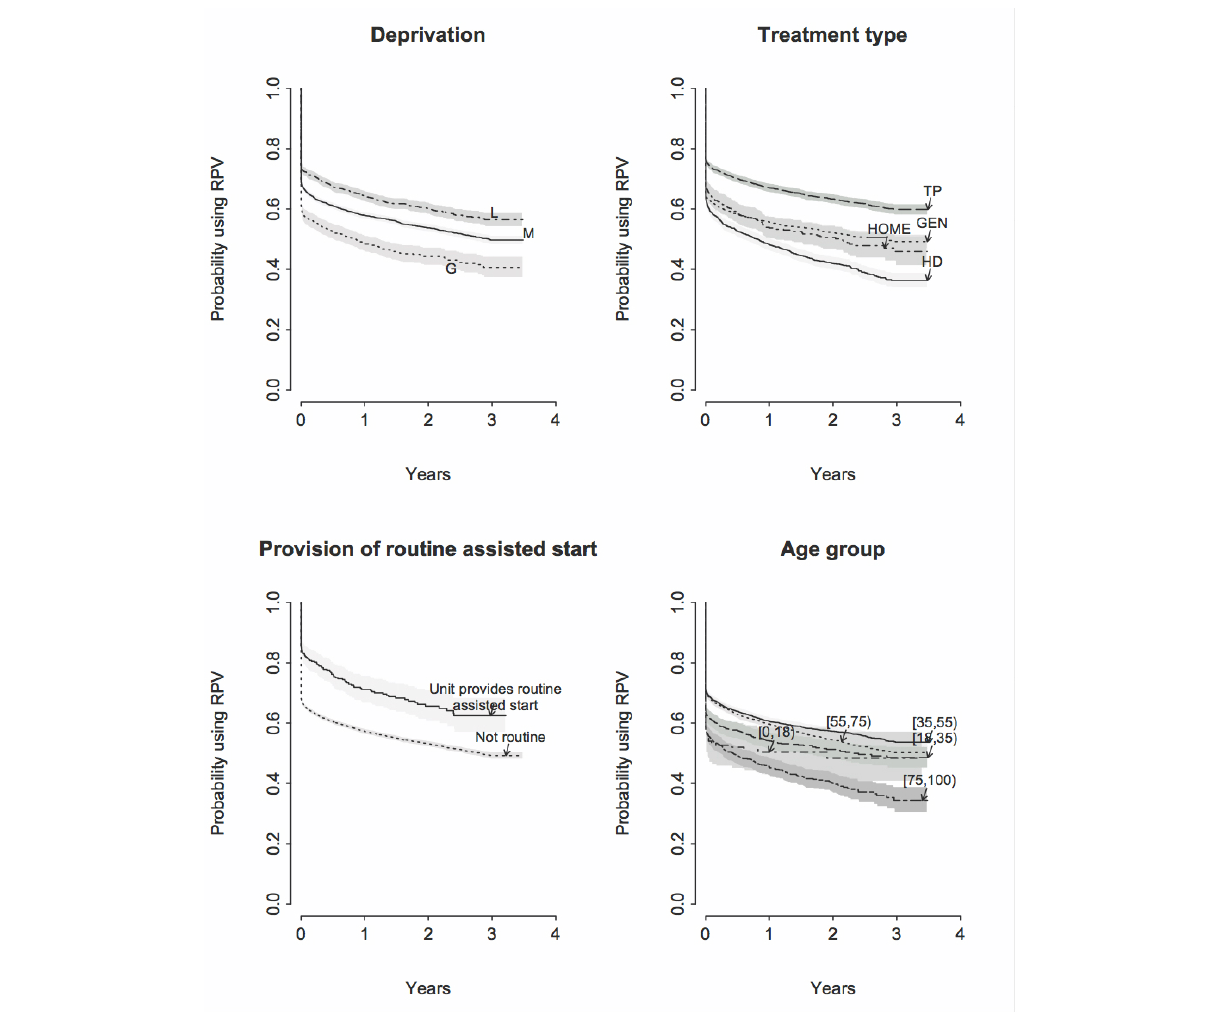
Figure 5. Probability of persisting use of RPV at intervals after registration shown as survival (of RPV use) classified as shown. Shading indicates 95% confidence